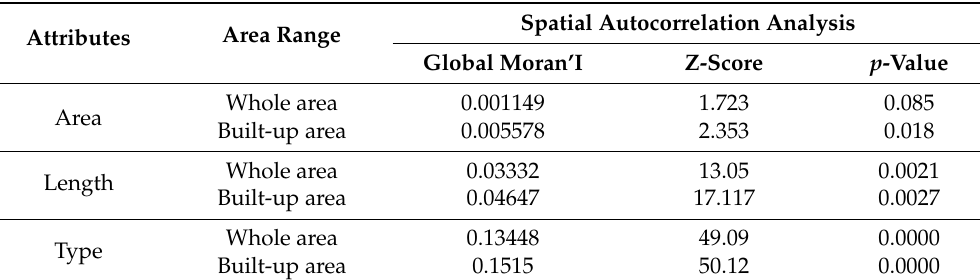
Figure 4. Global autocorrelation analysis results of public open spaces in terms of area: ( a ) whole area; ( b ) built-up area. Table 1. Statistic results of spatial global autocorrelation analysis.